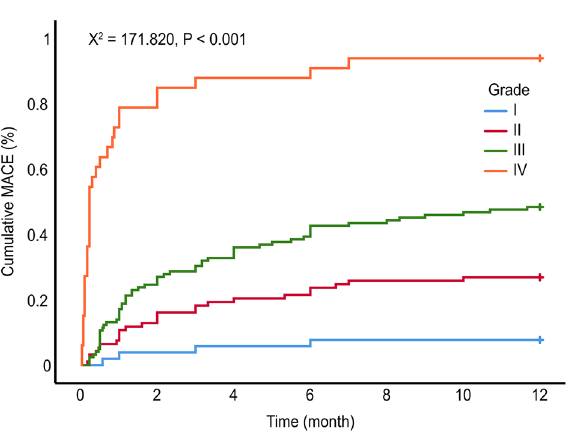
Figure 2. Kaplan ‒ Meier curves indicating composite MACE (angina, recurrent myocardial infarction, arrhythmia, heart failure, and all-cause